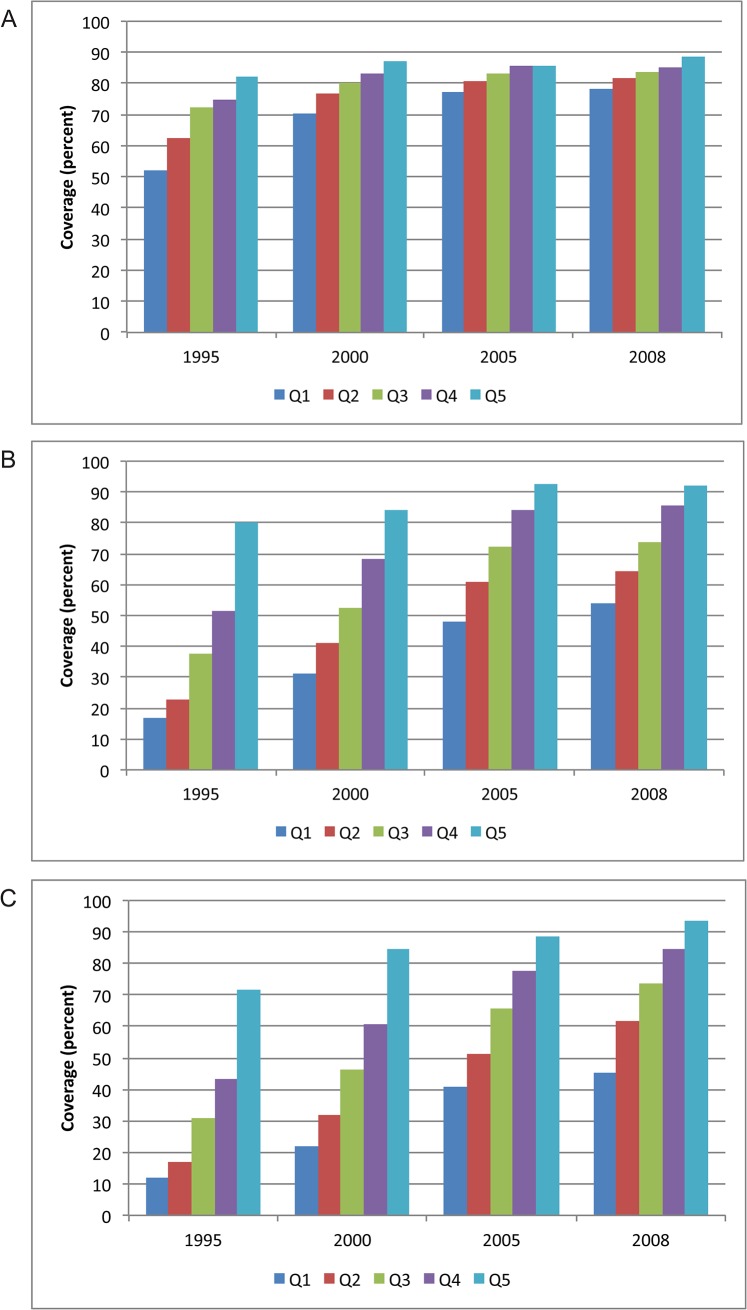
Distribution of reproductive and maternal health service coverage in Egypt, by wealth quintile, 1995–2008.(A) Demand met for family planning. (B) Antenatal care. (C) Facility delivery. Q1-5 = wealth quintiles from poorest to wealthiest households. CI = concentration index.